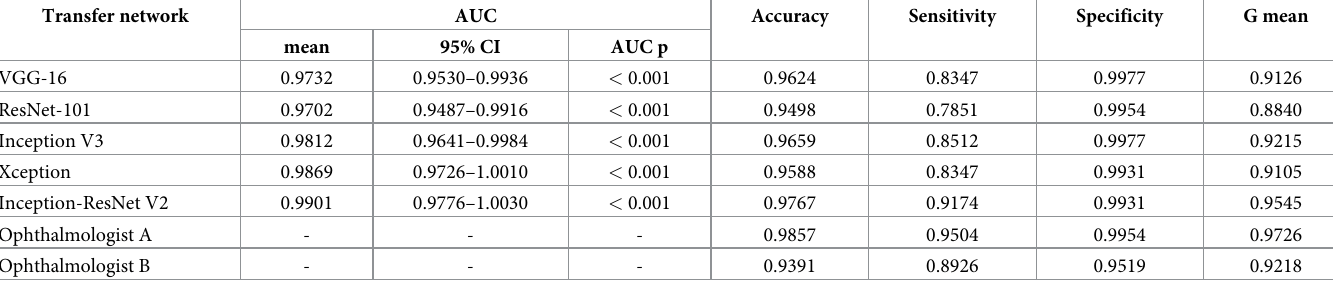
Table 2. External validation results of five transfer networks and two ophthalmologists in detecting inflammatory